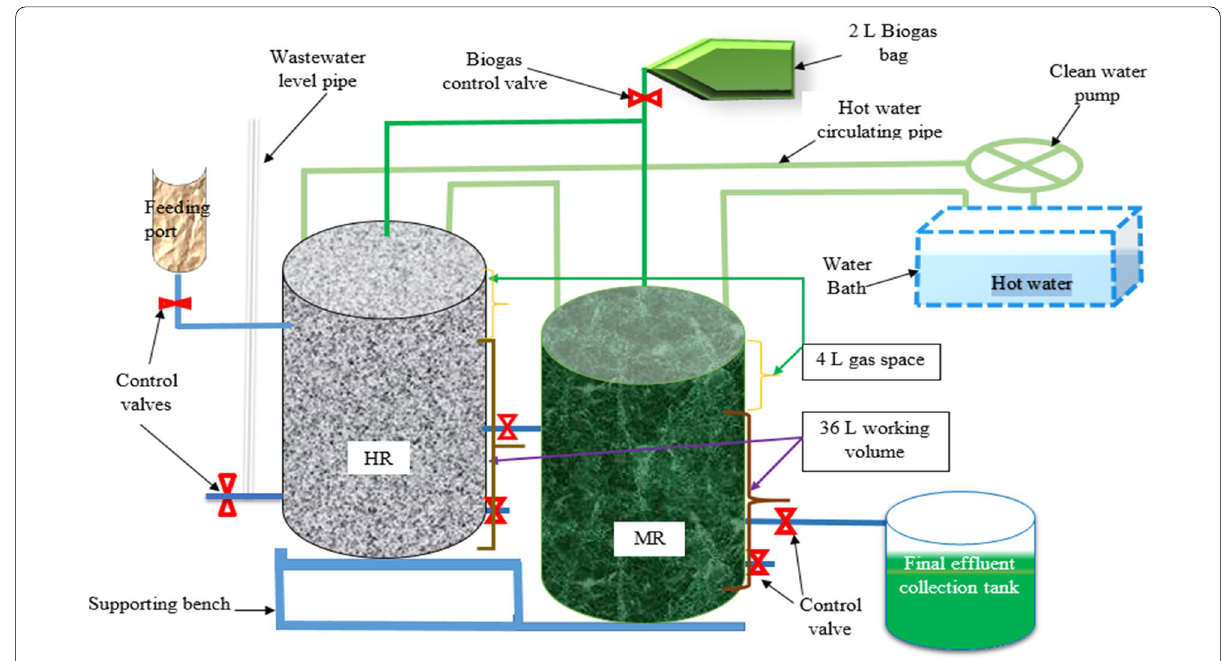
Fig. 1 Schematic diagram of the bench-scale two-phase AD experimental setup